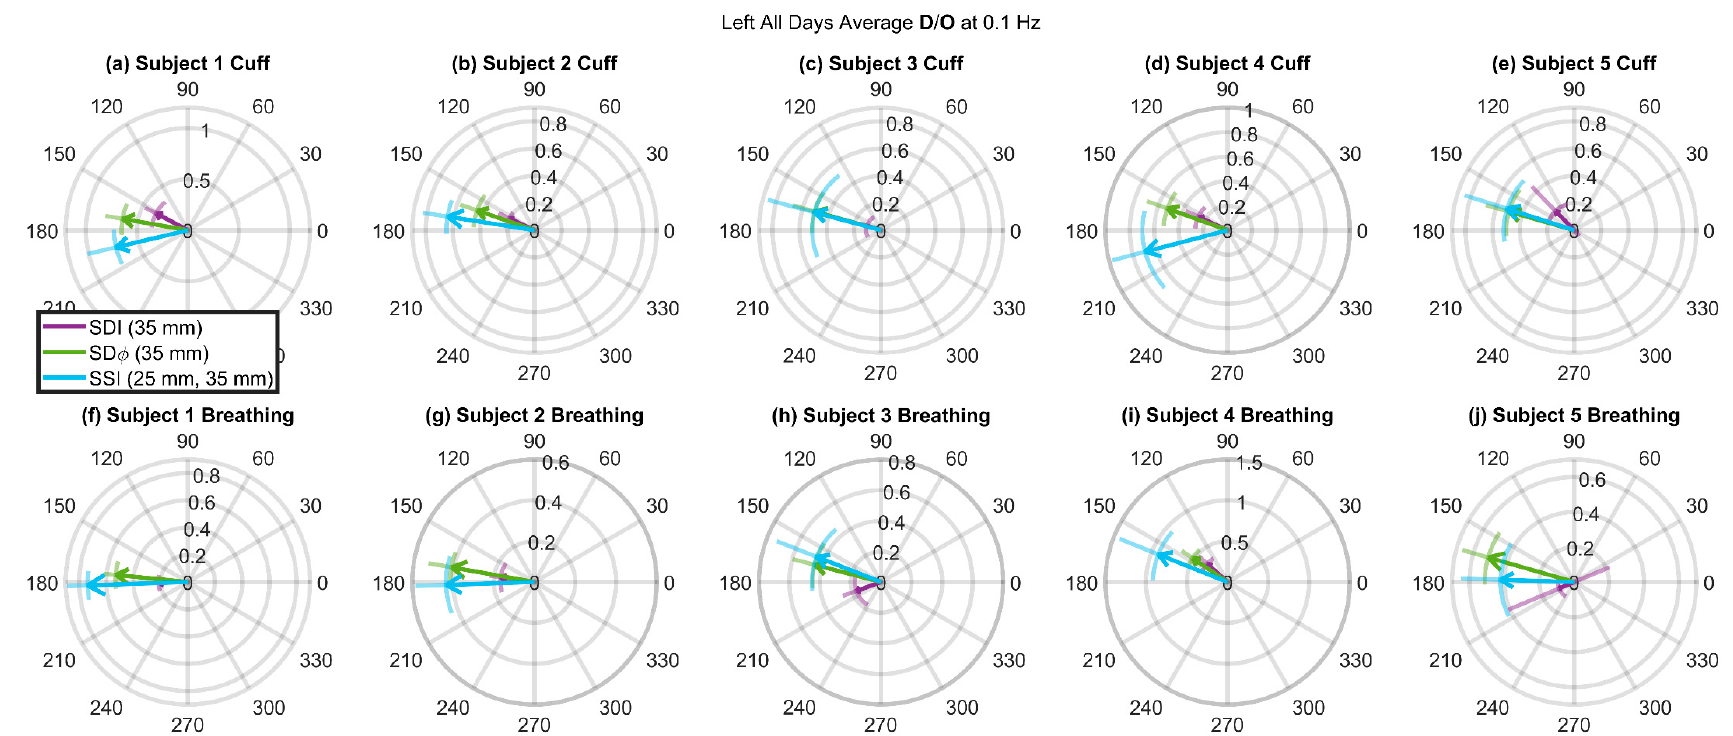
Figure 6. Vectors D / O whose magnitude and phase represent the amplitude ratio and the phase difference, respectively of the deoxyhemoglobin ( D ) and oxyhemoglobin ( O ) phasors at 0.1 Hz. The D / O vectors are averaged over all days for each subject at one location (left side of the forehead). Error bars are shown as arcs for the phase and line segments extending from the arrow point for the amplitude. Three measurement methods are shown: single-distance intensity (SDI, purple), single-distance phase (SD ϕ , green), and single-slope intensity (SSI, cyan). ( a – e ) Refer to the cyclic cuff inflation protocol, whereas ( f – j ) refer to the paced breathing protocol. Each column ( a,f ), ( b,g ), ( c,h ), ( d,i ), and ( e,j ) refers to one subject, as indicated in the title of each rose. Note: Error bars show standard deviation of all analyzed pixels over all days that show significant coherence in the wavelet transfer function scalogram.